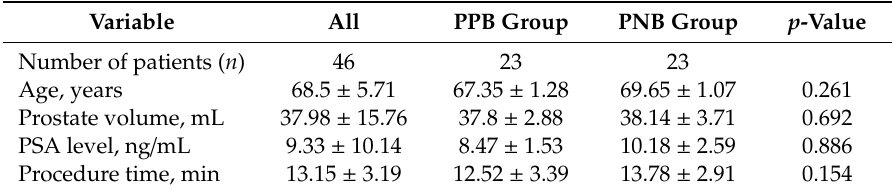
Table 1. Patient characteristics in the PPB and PNB treatment groups.